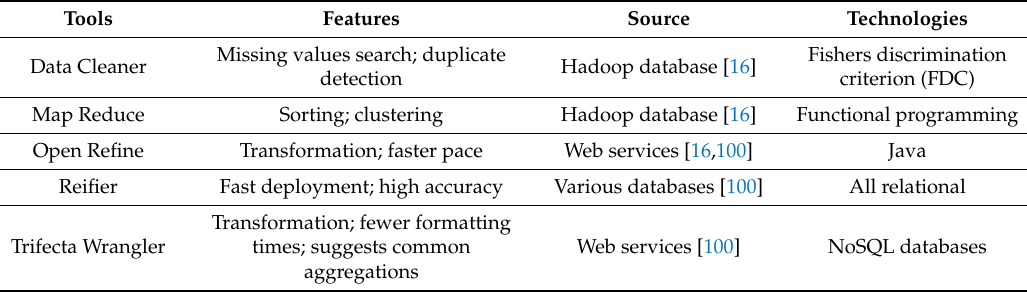
Table 10. Comparison of data cleaning tools.